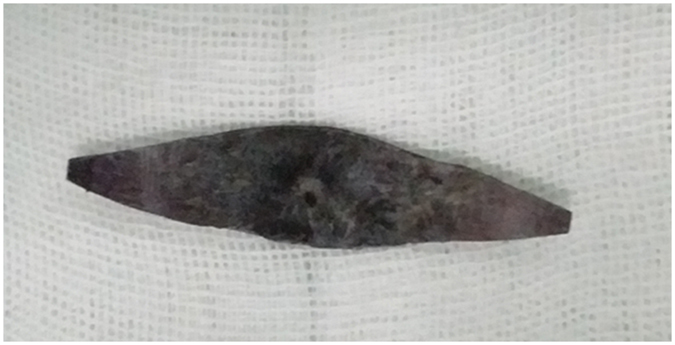
The genipin-cross-linked sclera used in posterior scleral contraction (PSC) surgery.The donor sclera was cut into spindle strips.